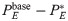
Dependence of global phase-locking changes on the baseline state of the brain network model.(A) The left axis (gray) shows the network-averaged baseline PLV ρglobal as a function of background drive PEbase-PE* for a coupling C = 2.5. The right axis (purple) shows the grand average 〈|Δρbase|〉 of the perturbation-induced absolute changes in baseline band PLVs as a function of PEbase-PE*. (B) The left axis (gray) shows the network-averaged baseline PLV ρglobal as a function of background drive PEbase-PE* for a coupling C = 2.5. The right axis (purple) shows the coefficient of variation of the perturbation-induced average absolute changes in baseline band PLVs, CoV[〈|Δρδibase|〉], as a function of PEbase-PE*. (C) The left axis (gray) shows the network-averaged baseline PLV ρglobal as a function of background drive PEbase-PE* for a coupling C = 2.5. The right axis (green) shows the grand average 〈|Δρexc|〉 of the perturbation-induced absolute changes in excited band PLVs as a function of PEbase-PE*. (D) The left axis (gray) shows the network-averaged baseline PLV ρglobal as a function of background drive PEbase-PE* for a coupling C = 2.5. The right axis (green) shows the standard deviation of the perturbation-induced average absolute changes in excited band PLVs, std[〈|Δρδiexc|〉], as a function of PEbase-PE*. (Note that here we consider the standard deviation rather than the coefficient of variation since the mean response in the excited band eventually drops to zero.).